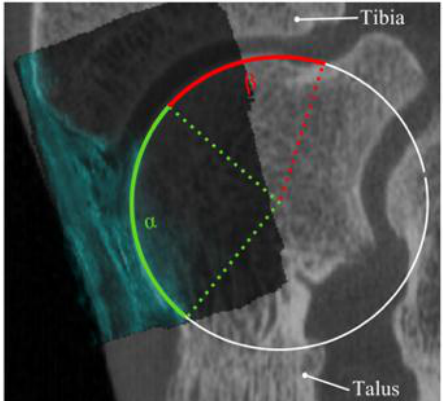
Figure 4. Sagittal view of one of the US volumes registered to the CT scan. The visible cartilage and cartilage covered by the tibia are represented, respectively, with α and β. The percentage of the visible cartilage was defined as the ratio of α to α + β (i.e., the total cartilage surface).